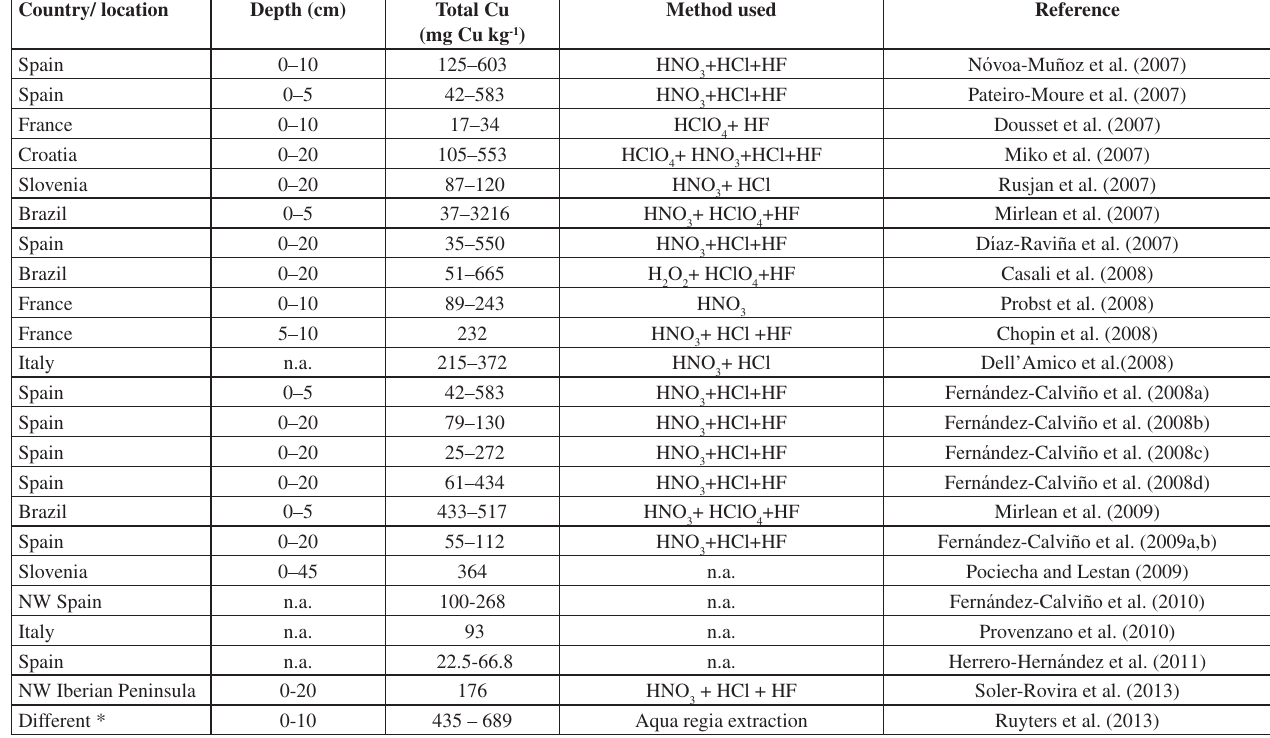
Table 2: Total Cu concentration (mg Cu kg -1 soil) and used methods in upper layers of vineyard soils as published in literature from 2007 to 2013 Country/